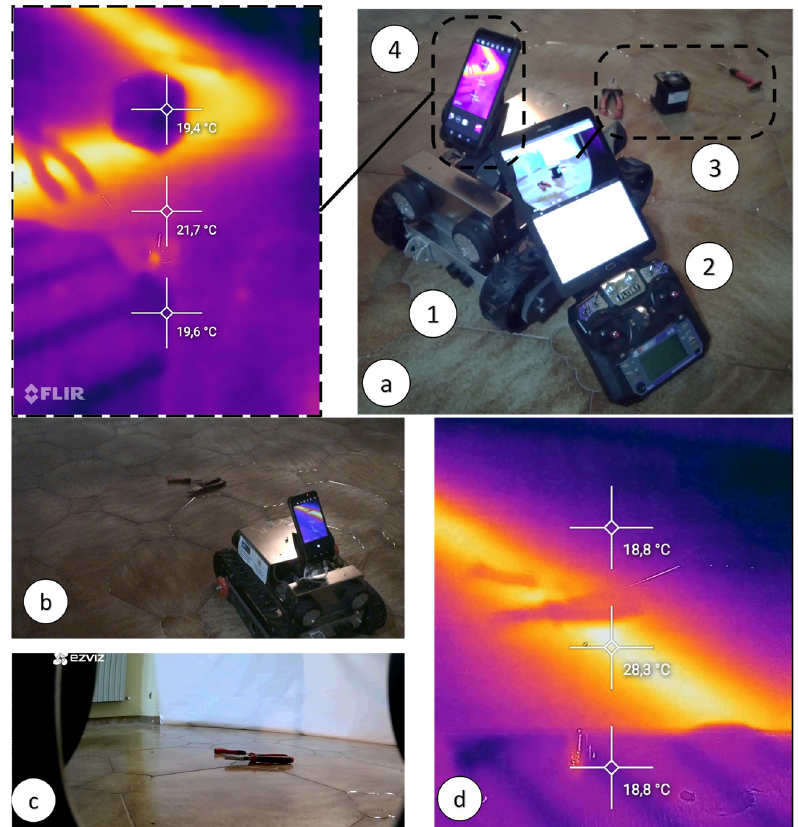
Figure 4. Scheme for the external sensor suite: ( a ) overall set-up 1 rover, 2 remote controller, 3 objects, 4 thermal imaging camera with zoomed view of the display; ( b ) indoor tests; ( c ) view from the onboard camera; ( d ) display of the thermal camera.